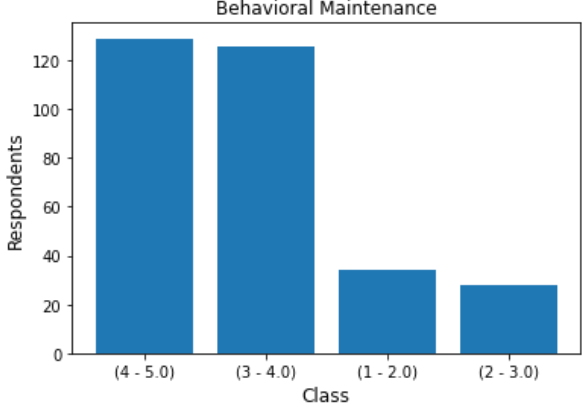
Figure 2: Number of respondents for each class; Source: Adopted by authors